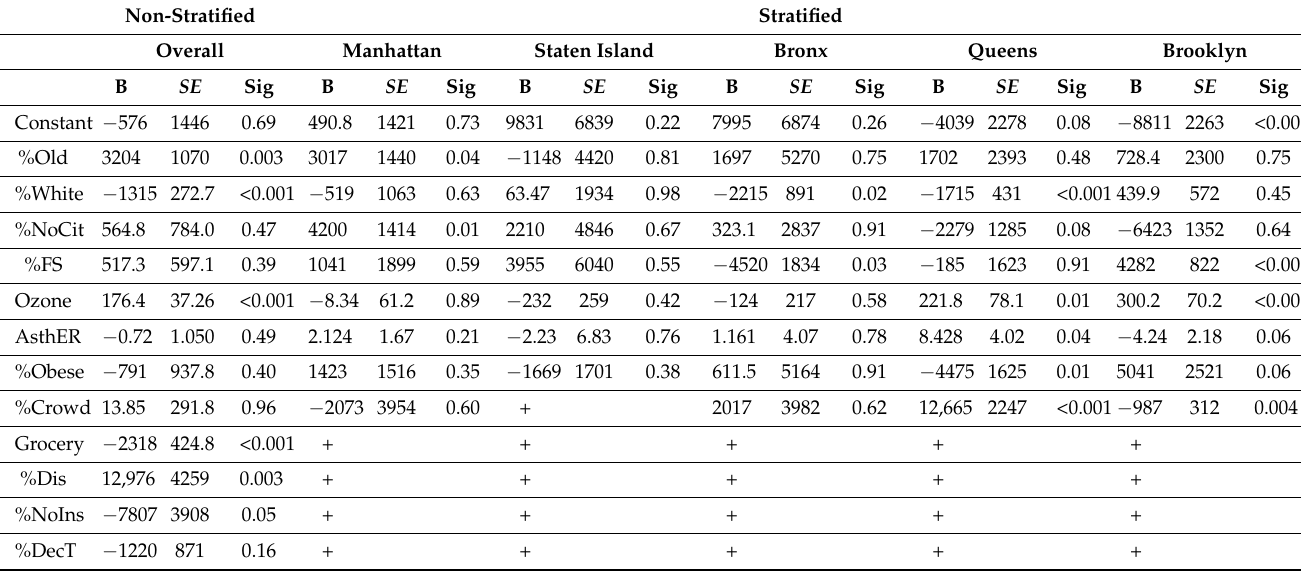
Table 5. Multiple regression of predicting New York City COVID-19 case rates per 100,000 residents, both non-stratified and stratified by borough.